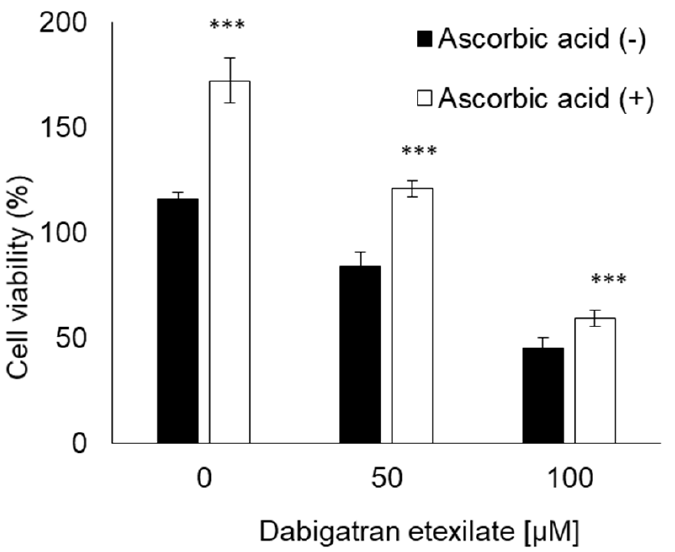
Figure 5. The cytotoxicity effect of dabigatran etexilate. Ascorbic acid prevented the dabigatran etex- ilate-induced cell injury. Data are expressed as means ± SD (n = 6). *** p < 0.001.